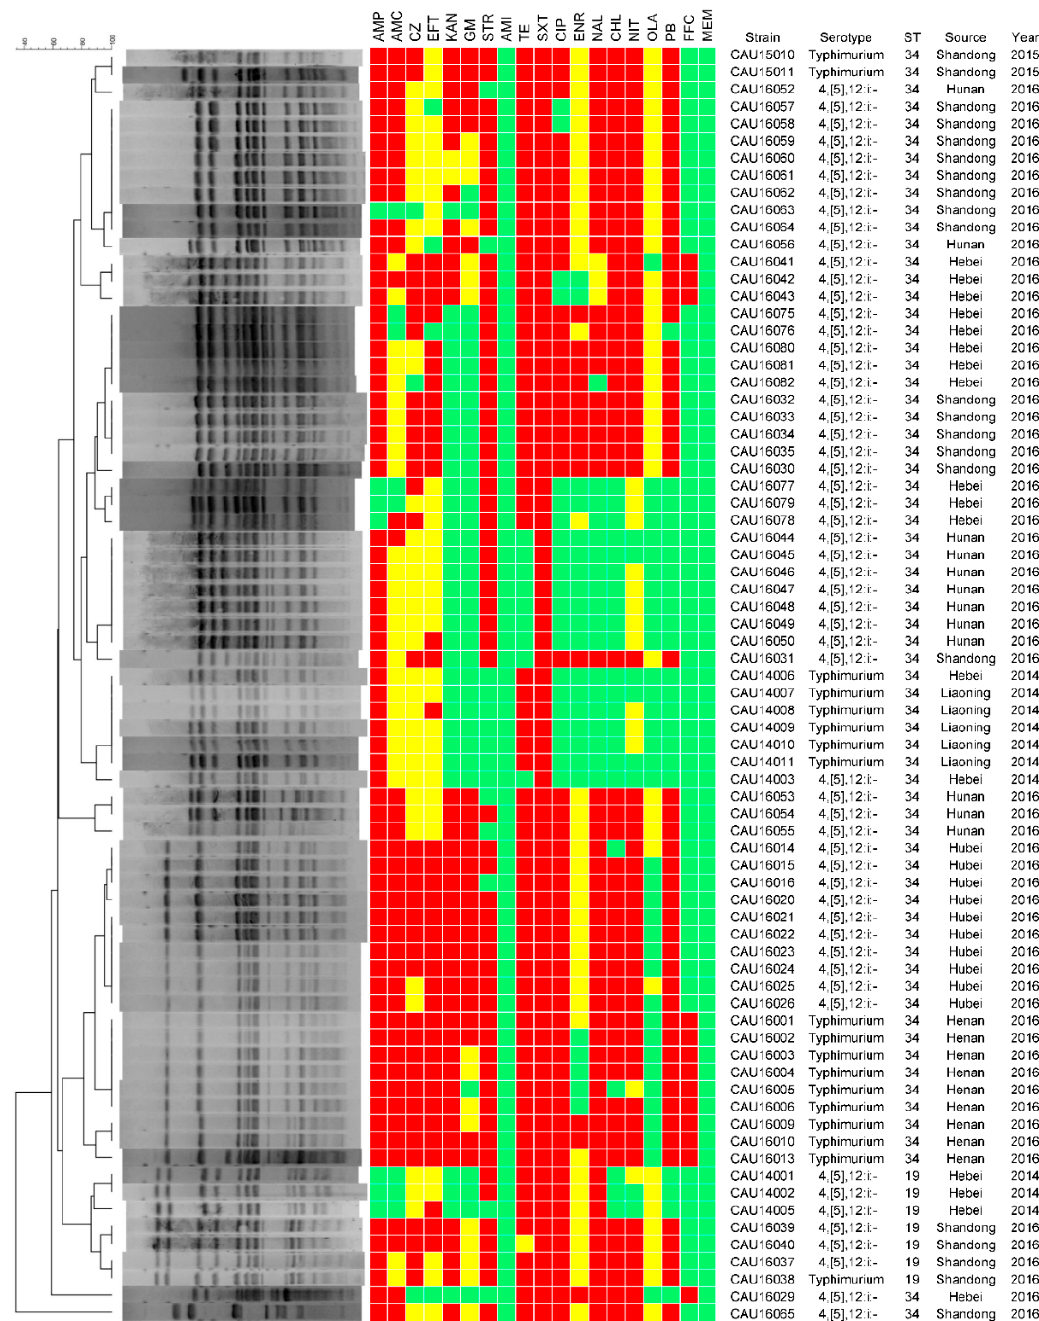
Figure 3. PFGE patterns and antimicrobial resistance profiles of all the S. Typhimurium and S. 4,[5],12:i:-. Dendrograms of Xba I-PFGE are presented on the left, and the results of the antimicrobial susceptibility tests are shown to be aligned with the dendrograms. Red indicates resistance to the corresponding antimicrobials, yellow indicates intermediate susceptibility, and green indicates susceptibility.